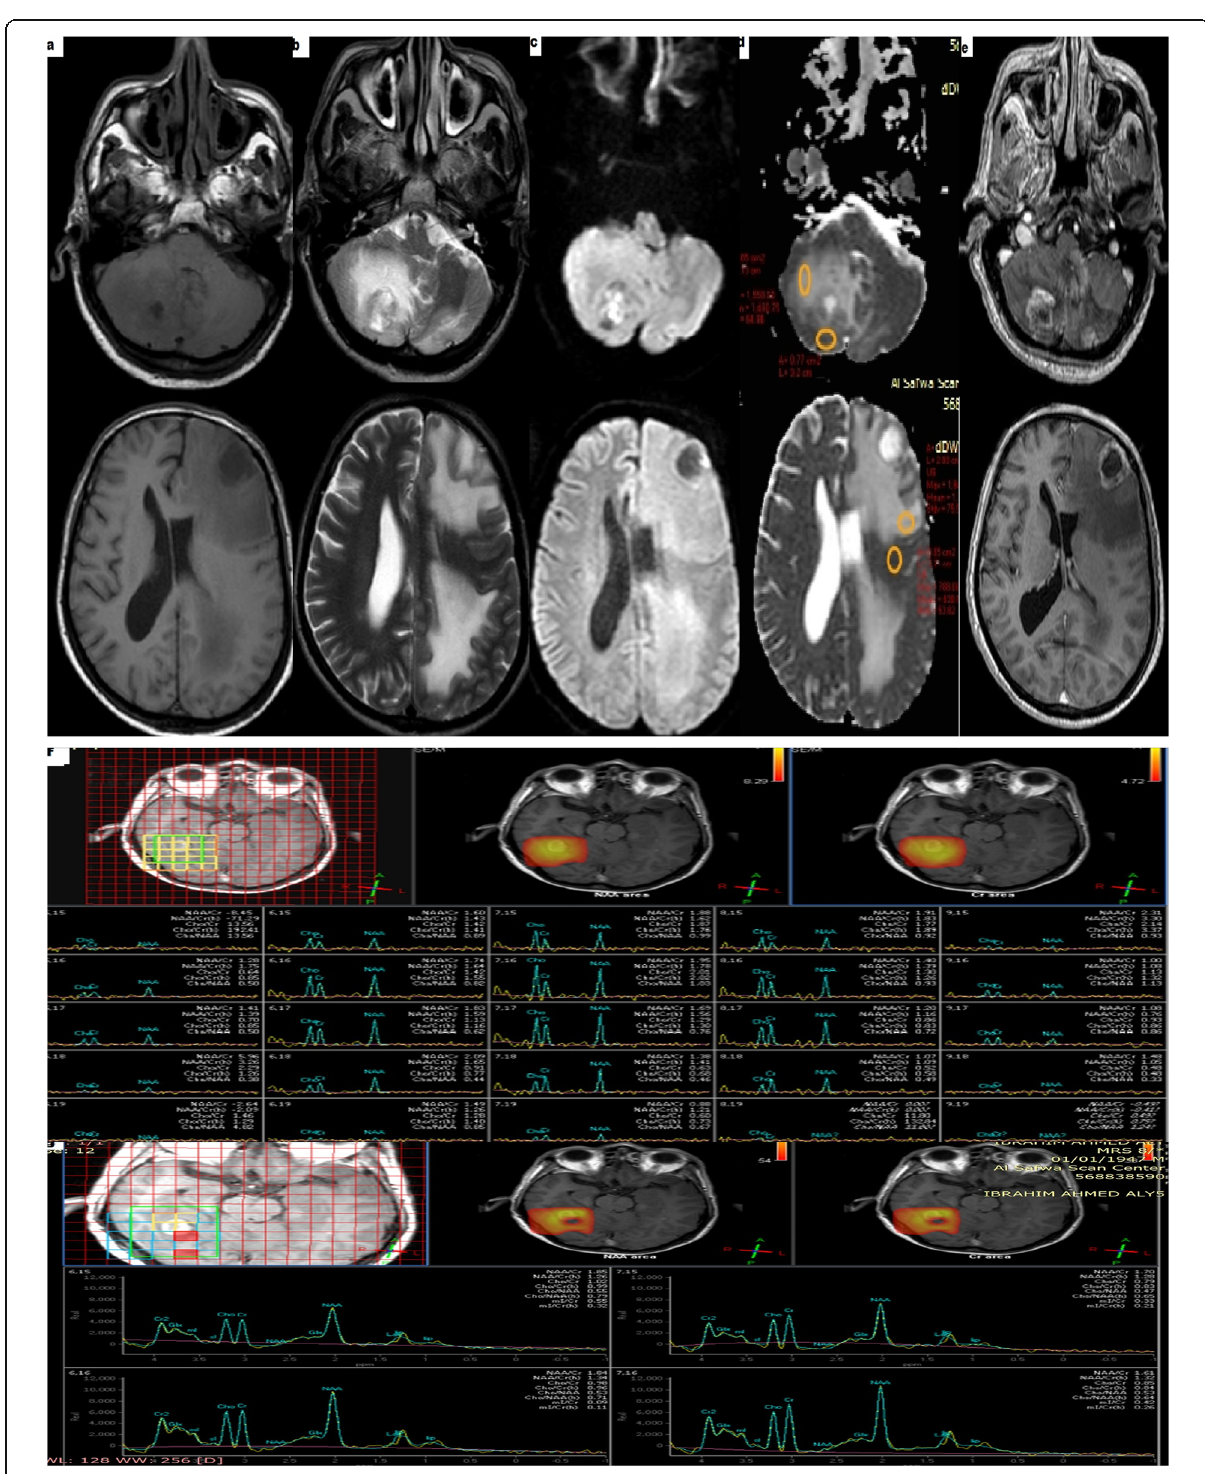
Fig. 3 “ A 52-year-old female patient ” with known primary breast Ca, MRI exam revealed multiple semi-defined intra-axial SOLs shown in images at cerebellum and both cerebral hemispheres, iso-hypointense at T1 ( a ) and hyper at T2 ( b ) that surrounded with moderate edema. DWI and ADC map ( c , d ) showed diffusion restriction with low ADC values. Post Gad ( e ) showed peripheral nodular contrast enhancement. MRS ( f , g ) revealed marked reduction of NAA and Cr peaks with elevated Cho within the lesions with normal pre-lesional metabolites. MRI diagnosis: metastatic breast Ca. Pathology: proved metastatic